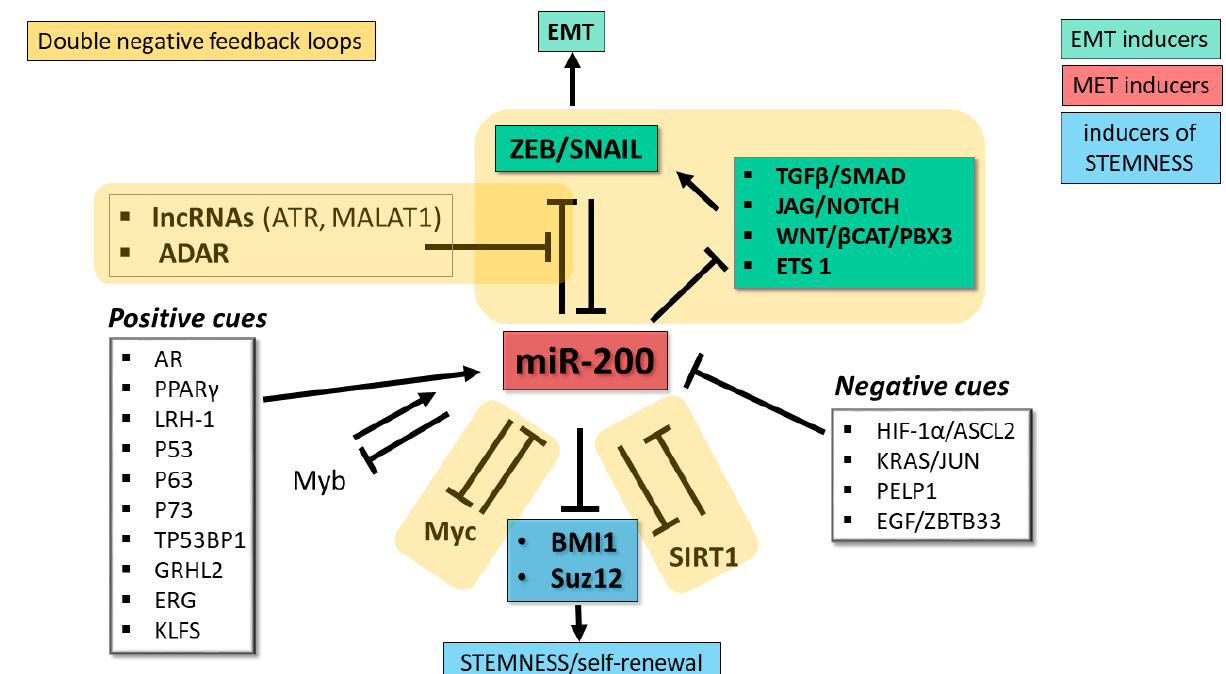
Figure 2. Regulatory networks involving miR-200 family. miR-200 family members play a key role as repressors of factors driving EMT (green boxes) and stemness (blue box), two key hallmarks of tumor progression and invasive growth. The miR-200 family lies at the core of multiple double negative feedback loops (DNFL, indicated by yellow shaded areas) controlling EMT plasticity: one direct with the ZEB and SNAIL transcription factors, the other indirect through signaling pathways that control ZEB and SNAIL. Additional miR-200-based DNFL control Myc and SIRT1, two pervasive regulators of the cell’s transcriptional landscape. White boxes indicate major positive and negative cues controlling miR-200 expression. EMT, epithelial-mesenchymal transition. MET, mesenchymal-epithelial transition.